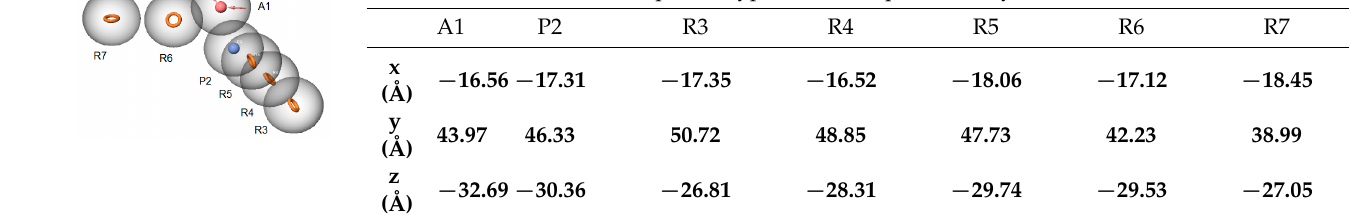
Table 6. Descriptors used in QSAR model for antimicrobial activity against S. aureus.